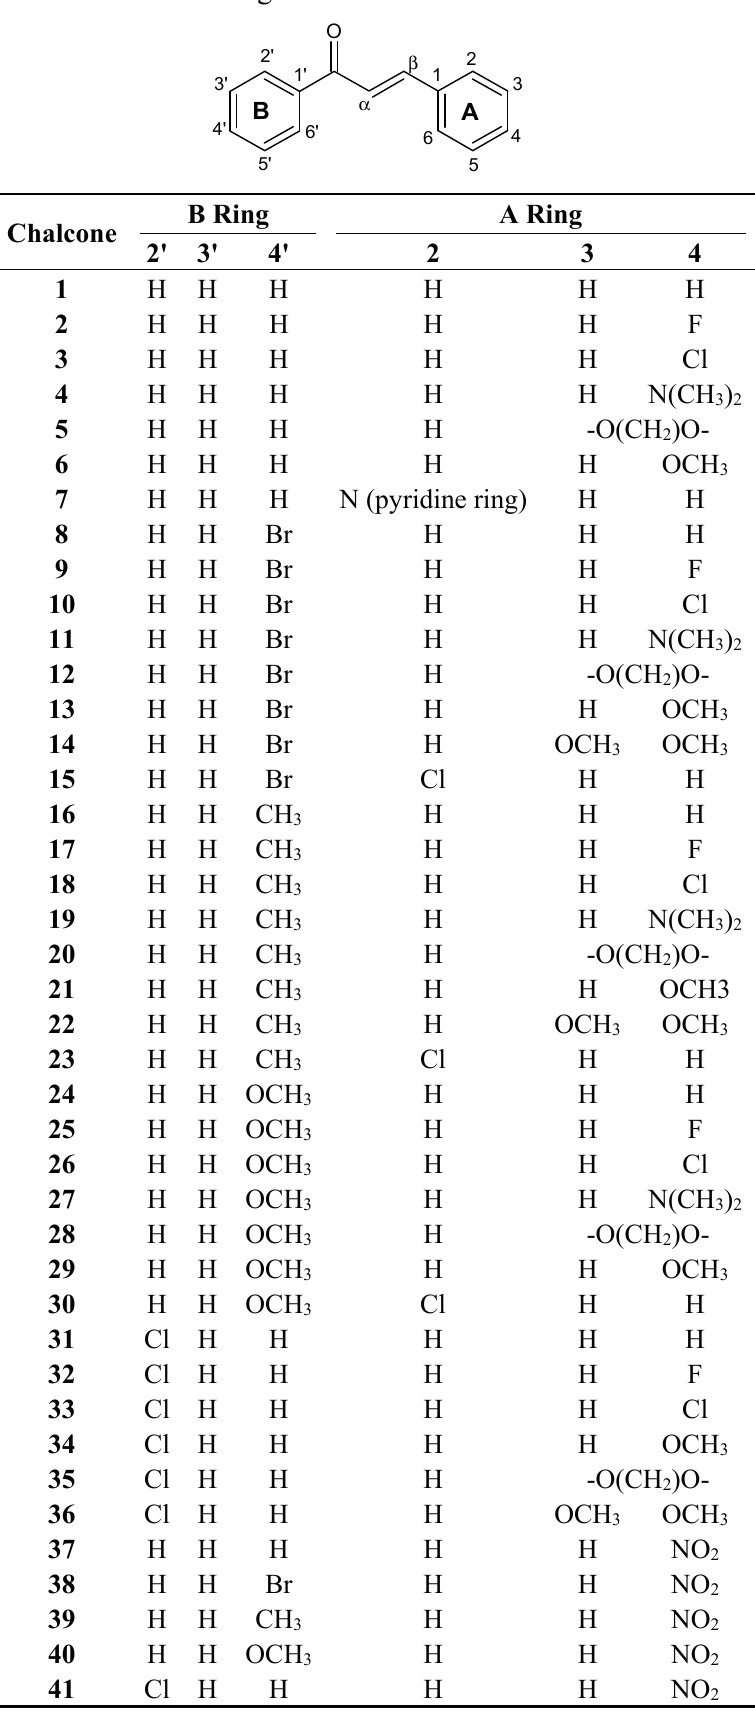
Table 1. Structures of representative unsubstituted chalcone and synthesized chalcones with substituents on the A and B rings.